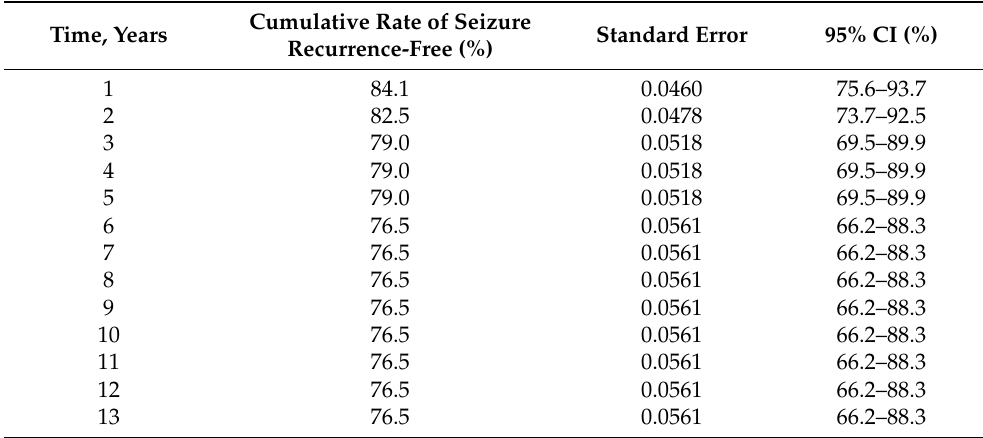
Table A1. Kaplan–Meier analysis of the cumulative rate of seizure